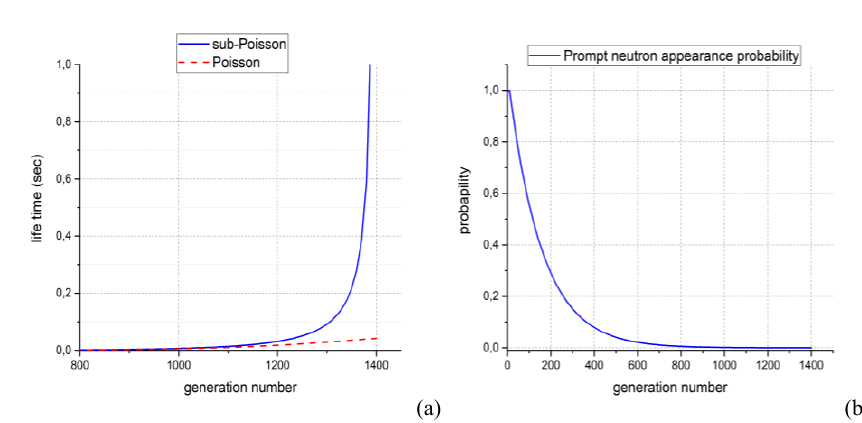
Fig. 2. The generation lifetime dependence (a) and prompt neutron appearance probability